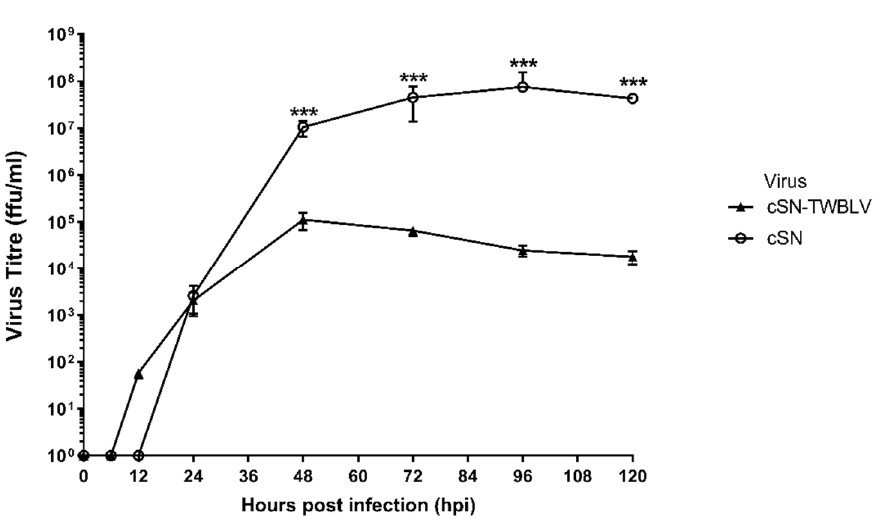
Figure 1. Growth kinetics of cSN-TWBLV and the vaccine backbone, cSN, in vitro. For each virus, BHK-21 cells were infected with an MOI of 0.1 to produce a multiple-step growth curve over the course of 120 h. The test was performed in triplicate and as three independent experiments where the mean and standard deviation of the results were plotted on a logarithmic scale. Asterisks indicate significant differences between the groups calculated using the Mann–Whitney test (*** p <